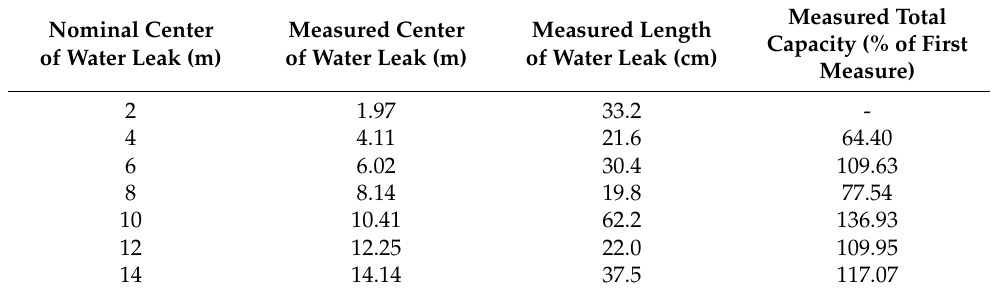
Figure 11. Results of the measurement phase for the reflectogram of Figure 8: ( a ) measured and fitting signal; ( b ) estimated additional capacitance profile.